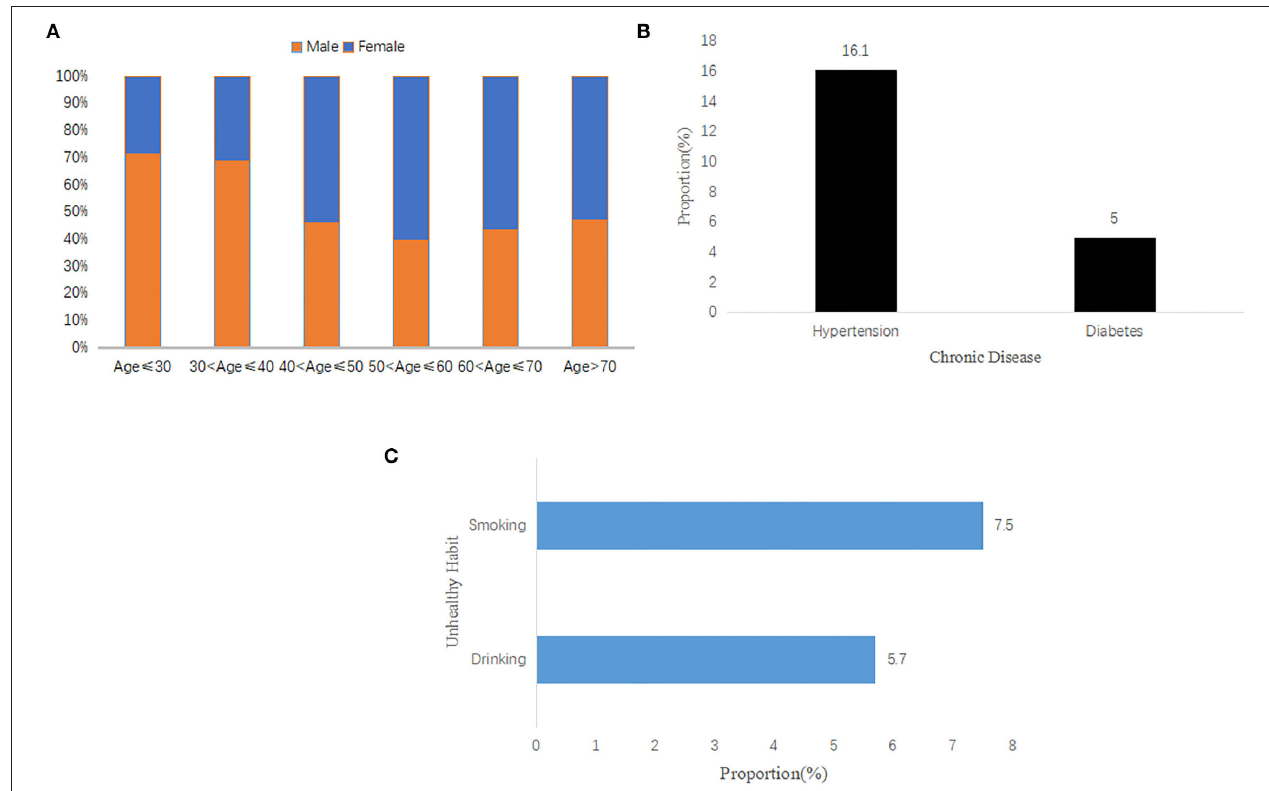
FIGURE 2 | Descriptive results about hospitalization records. (A) The proportion of gender distribution among different age groups; (B) the proportion of chronic disease among whole amount; (C) the proportion of unhealthy habits among whole amount.